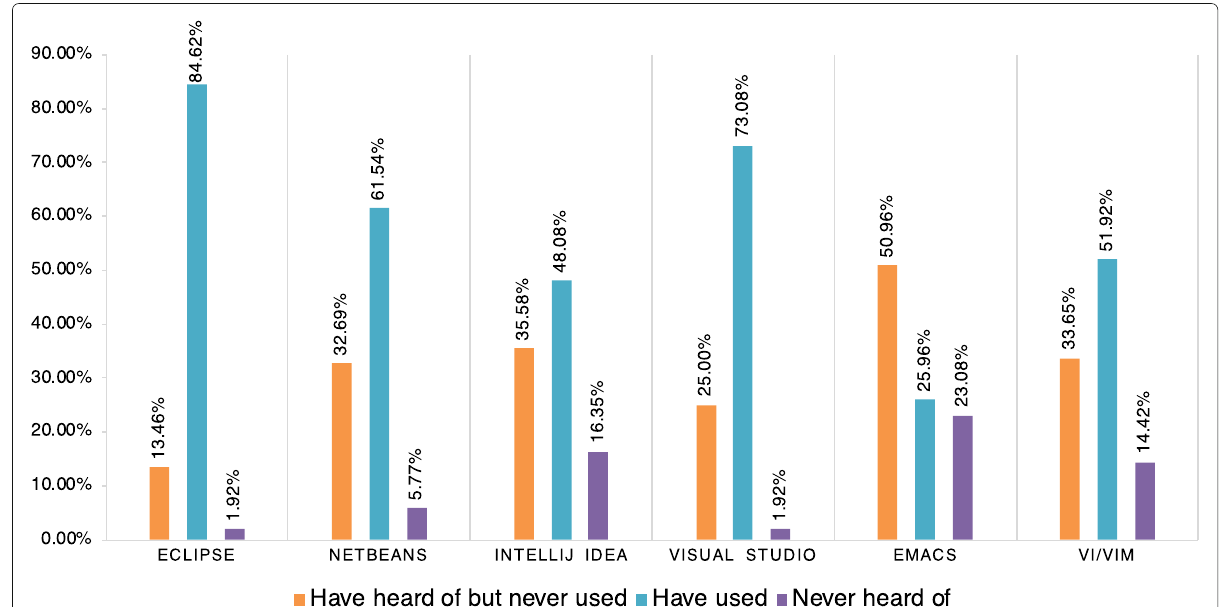
Fig. 4 Participants’ familiarity with IDEs